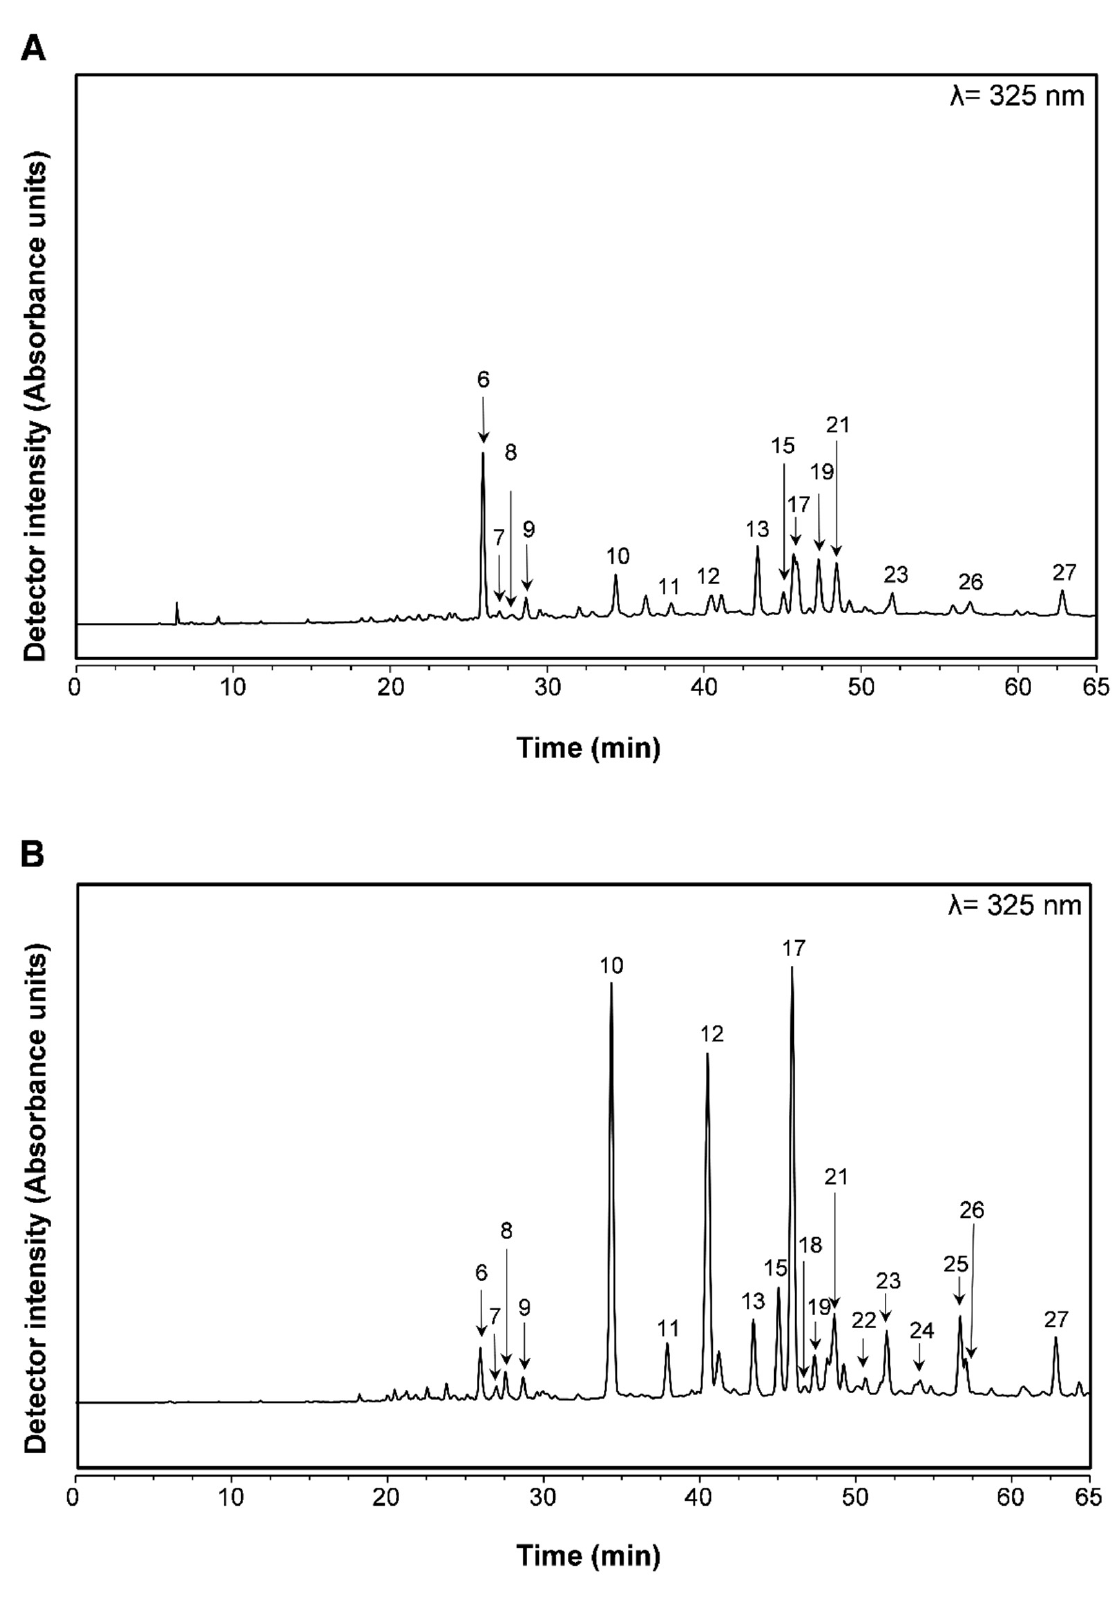
Figure 1. Phenolic profile of T. capitellatus aqueous decoction ( A ) and hydroethanolic ( B ) extracts obtained by HPLC-DAD analysis. For peak identification, please refer to Table 2.